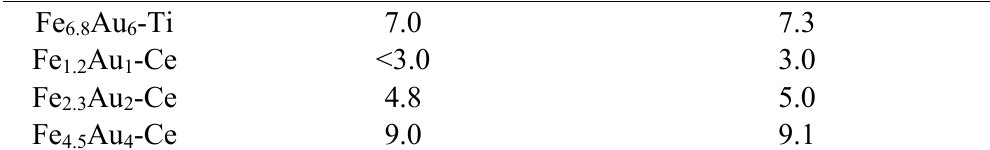
Figure 7. High Resolution TEM image of Fe